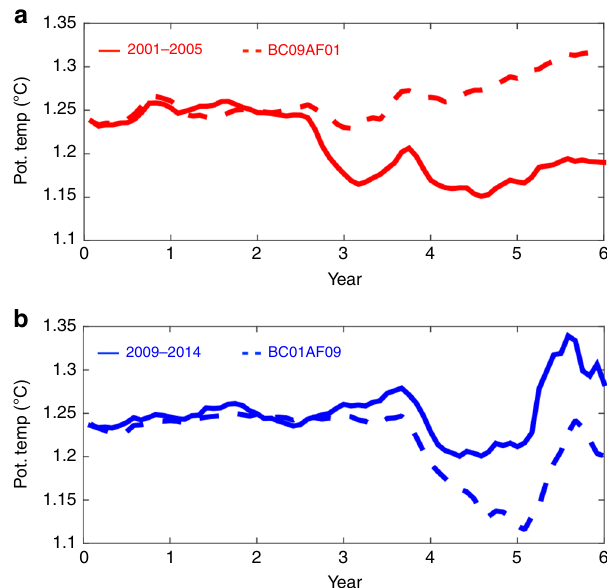
Fig. 7 Time series of volume-averaged CDW (with salinity higher than 34.65) potential temperature for the eastern AS region regions (enclosed by the gray lines in Fig. 1) near Pine Island Glacier. Time series are shown for a 2001 – 2006 (red) and BC09AF01 (red dashed) cases and b CTRL (2009 – 2014) (blue) and BC01AF09 (blue dashed) cases. The X -axes